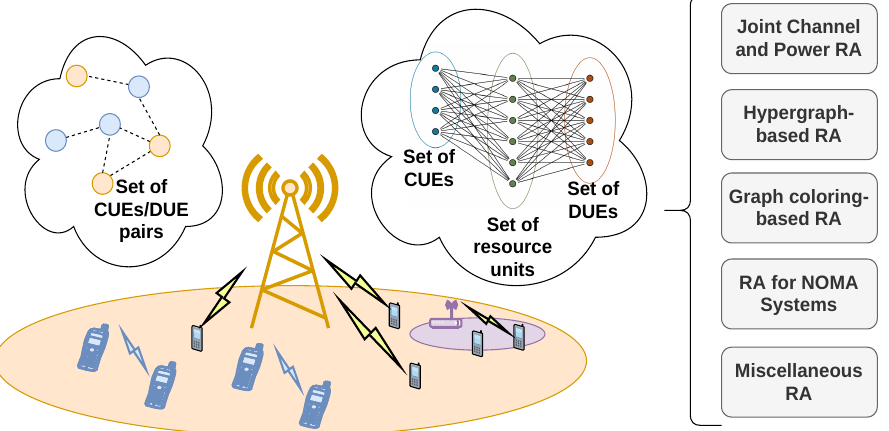
Figure 5. Scenario of D2D networks and summary of methods for graph-based